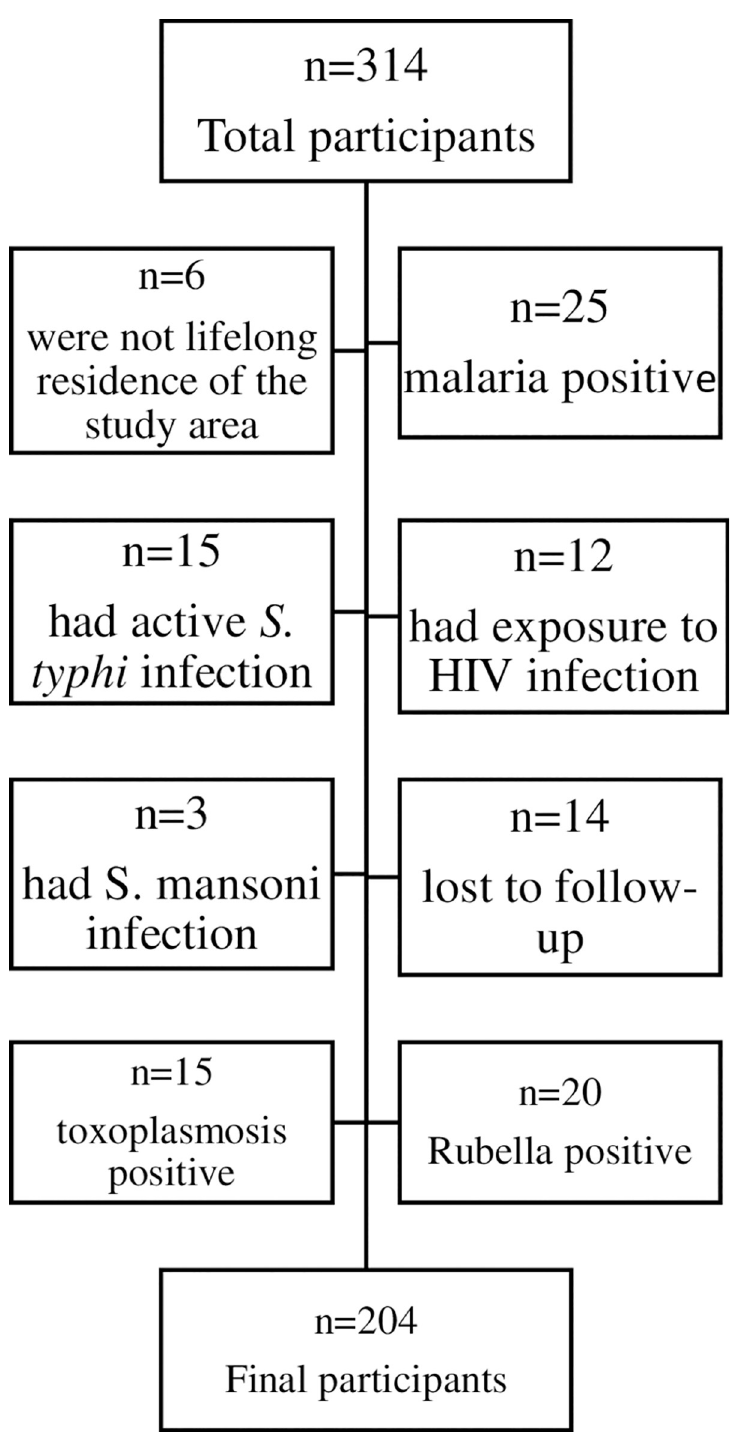
Fig 1. The Flow Chart showing the infections encountered in the study population and Selecting the Final Study Participants.